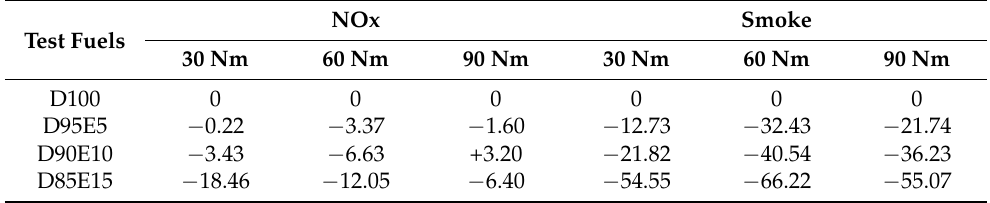
Figure 10. Smoke emissions for all test fuels according to various engine loads. Table 4. Addition of bioethanol improved improve the NOx-smoke trade-offs (“ − “ indicates decrease, “+” indicates increase, compared with diesel).